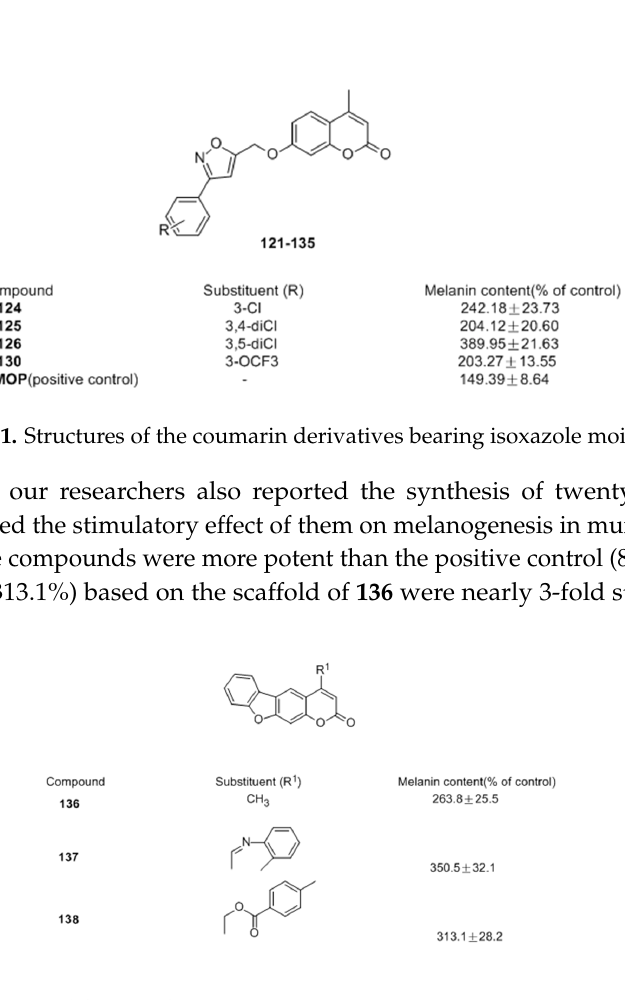
Figure 22. Structures of the synthesized furocoumarin derivatives.